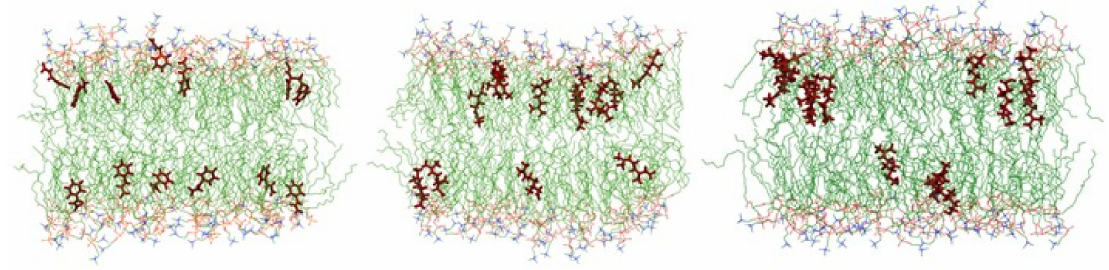
Figure 4. Snapshots after 100 ns of a 102 molecules palmitoyl linoleyl phosphatidylcholine (PLPC) and 26 molecules sitosterol bilayer with 13 CIN molecules (left panel), 13 CitA molecules (middle panel) and 13 CitO molecules (right panel). For the sake of clarity, water molecules are omitted. Dark red: herbicidal molecules, green: carbon atoms, red: oxygen atoms, orange: phosphor atoms, blue: nitrogen